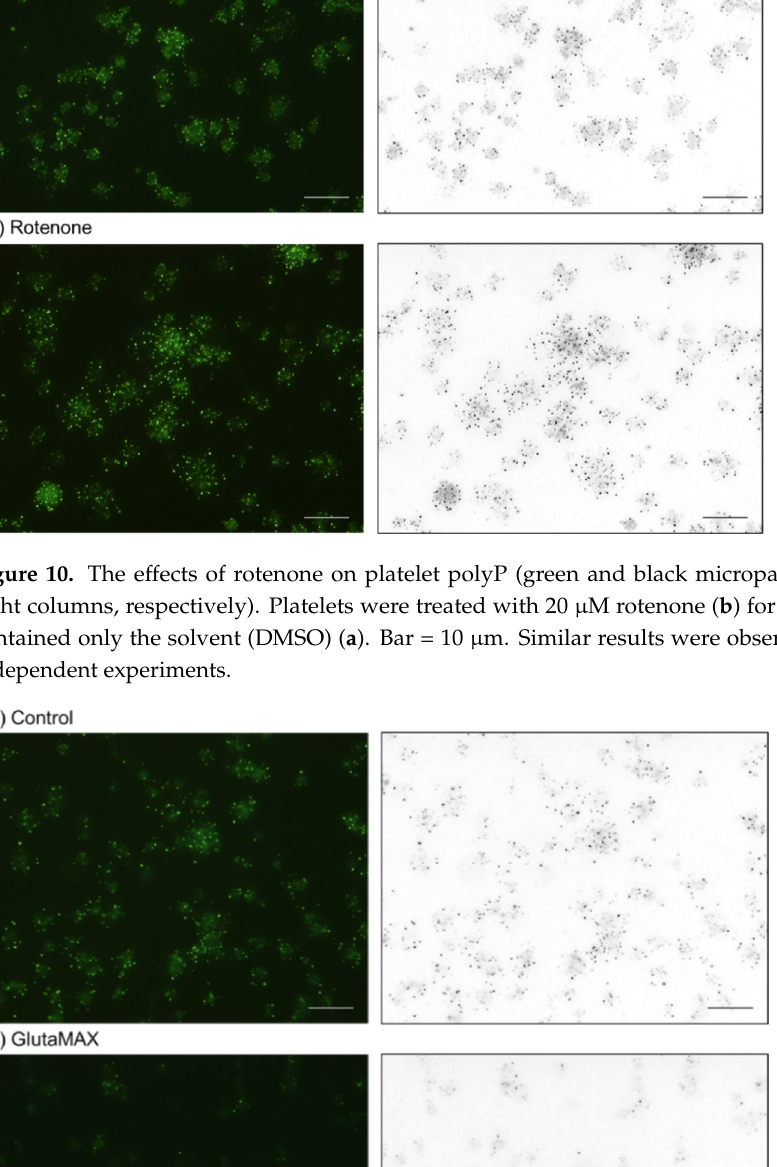
Figure 11. The effects of GlutaMAX on platelet polyP (green and black microparticles in left and right columns, respectively). Platelets were treated with 10% GlutaMAX ( b ) for 20 h. The control had no additions ( a ). Bar = 10 µ m. Similar results were observed in four other independent